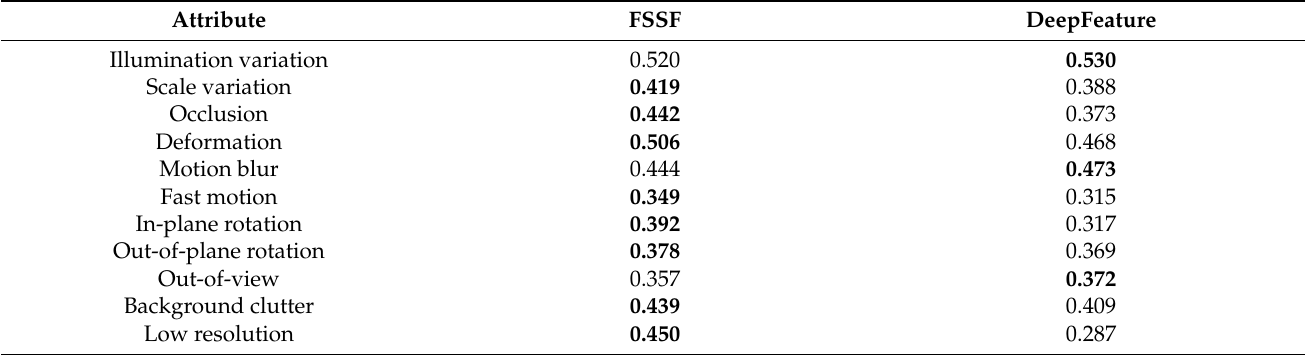
Table 5. Attribute-based comparison with DeepFeature in terms of mean OP (% at IOU>0.5). The best results are shown in bold, our FSSF ranks the first on 8 of 11 attributes: low resolution, background clutter, occlusion, out-of-plane rotation, in-plane rotation, fast motion, scale variation, and